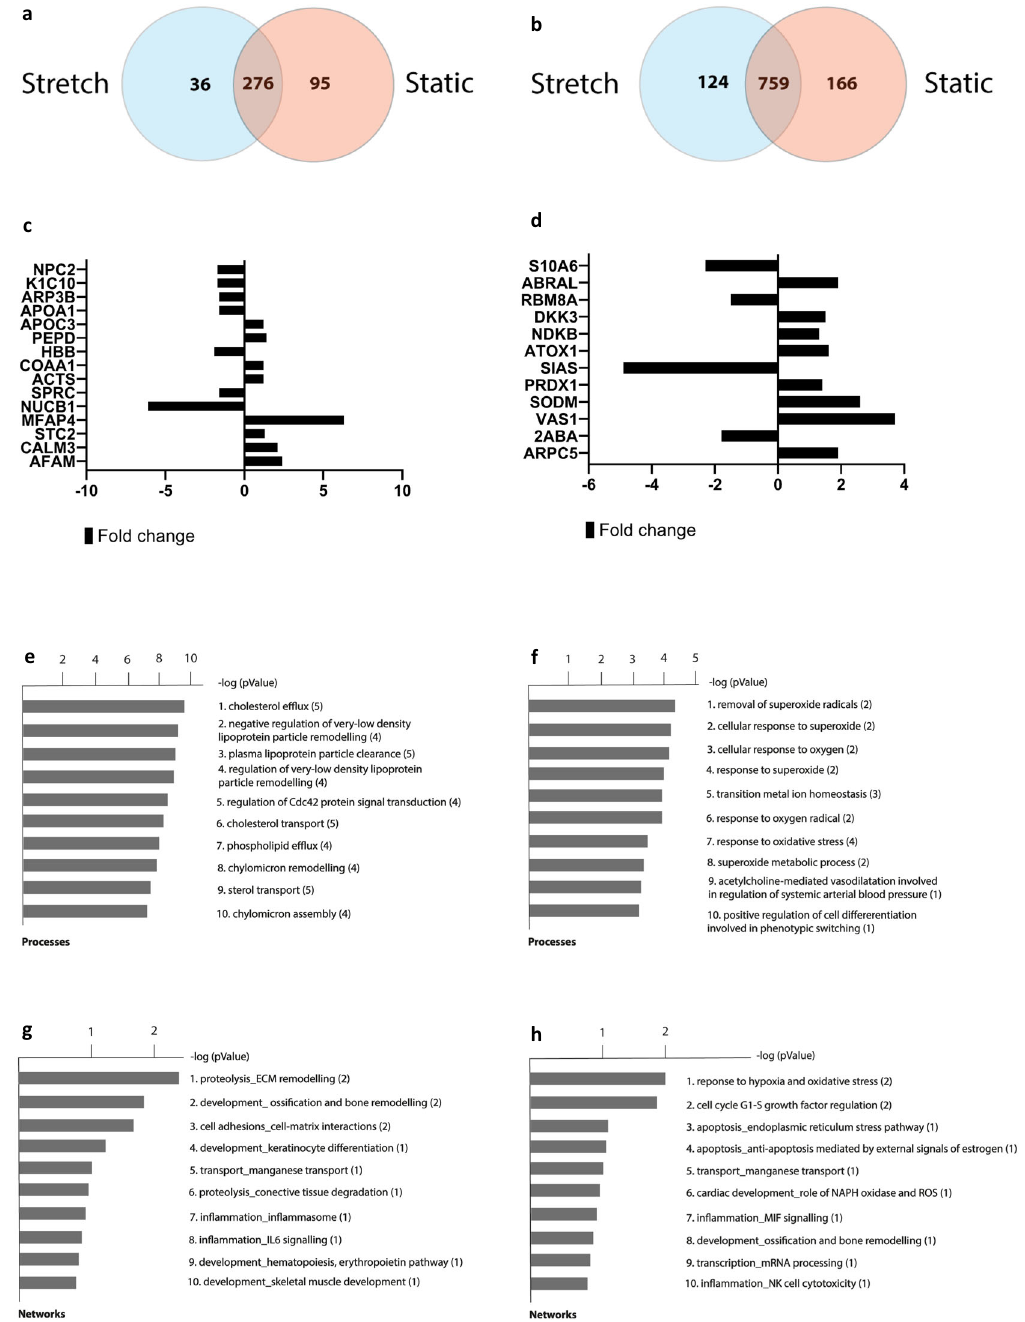
Fig. 2 Secretome analysis of murine and human osteocytic cells. Venn diagram of hSCO ( a ) and MLO-Y4 ( b ) showing the secreted molecules exclusive to mechanically active and static cell culture conditions; Protein expression fold change given for the stretch condition vs control group (static) in hSCO ( c ) and MLO-Y4 ( d ); Chart depicting top ten overrepresented biological processes in hSCO ( e ) and MLO-Y4 ( f ); Chart depicting top ten overrepresented process networks in hSCO ( g ) and MLO-Y4 ( h ); Number of overexpressed proteins in each enrichment score within brackets; n =